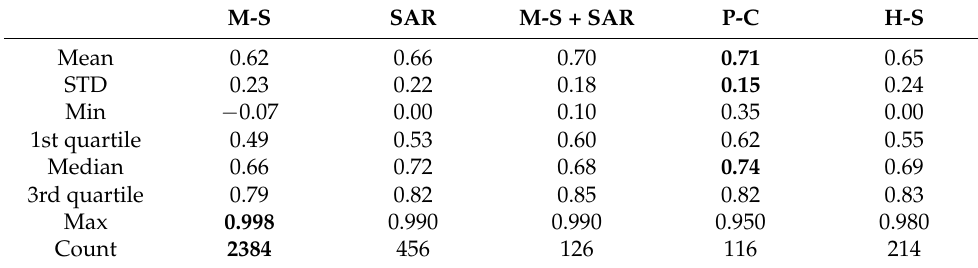
Table 9. Statistical analysis of R2 in various